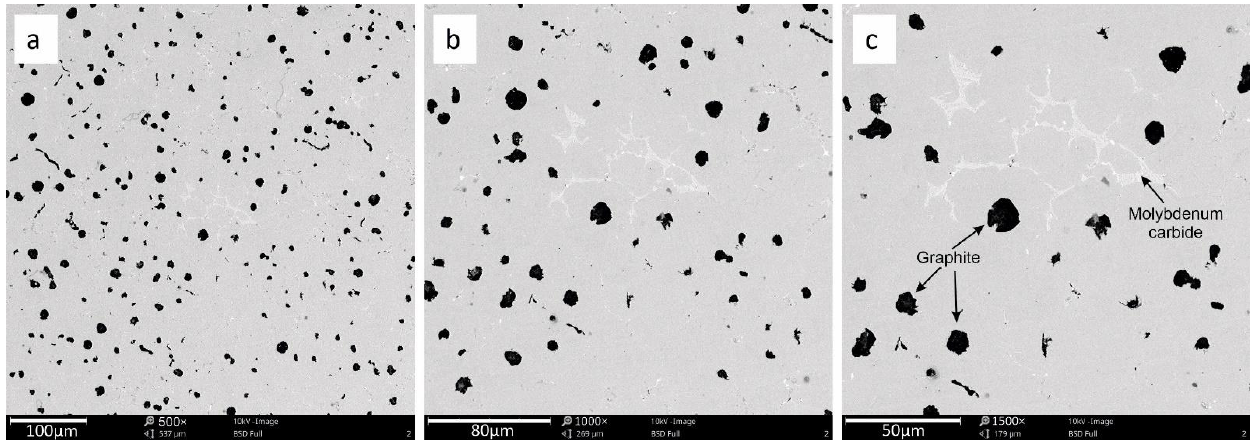
Figure 2. The cast iron microstructure for sample 2 with precipitation of graphite and molybdenum carbide. Magnification 500× ( a ), 1000× ( b ), 1500× ( c ).